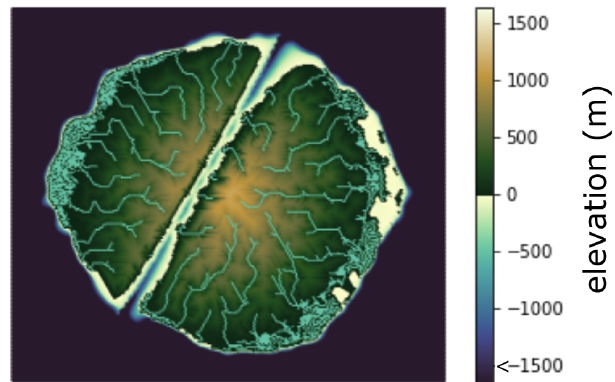
Figure 12. Snapshot of prototype integrated numerical model of landscape and sedimentary basin evolution. Domain size is 250 by 250km. Simulation shows a hypothetical micro-continent with an active NNE-oriented extensional fault. Sea level varies stochasti- cally; this particular snapshot captures a period of rising sea level after a brief low stand. Model was constructed using Landlab com- ponents for flow routing (FlowAccumulator, FlowDirectorSteepest, LakeMapperBarnes), fluvial processes (ErosionDeposition), marine sediment transport (SimpleSubmarineDiffuser), lithosphere flexure in response to loading and unloading (Flexure), and extensional faulting (ListricKinematicExtender). Color map designed by Thyng et al.